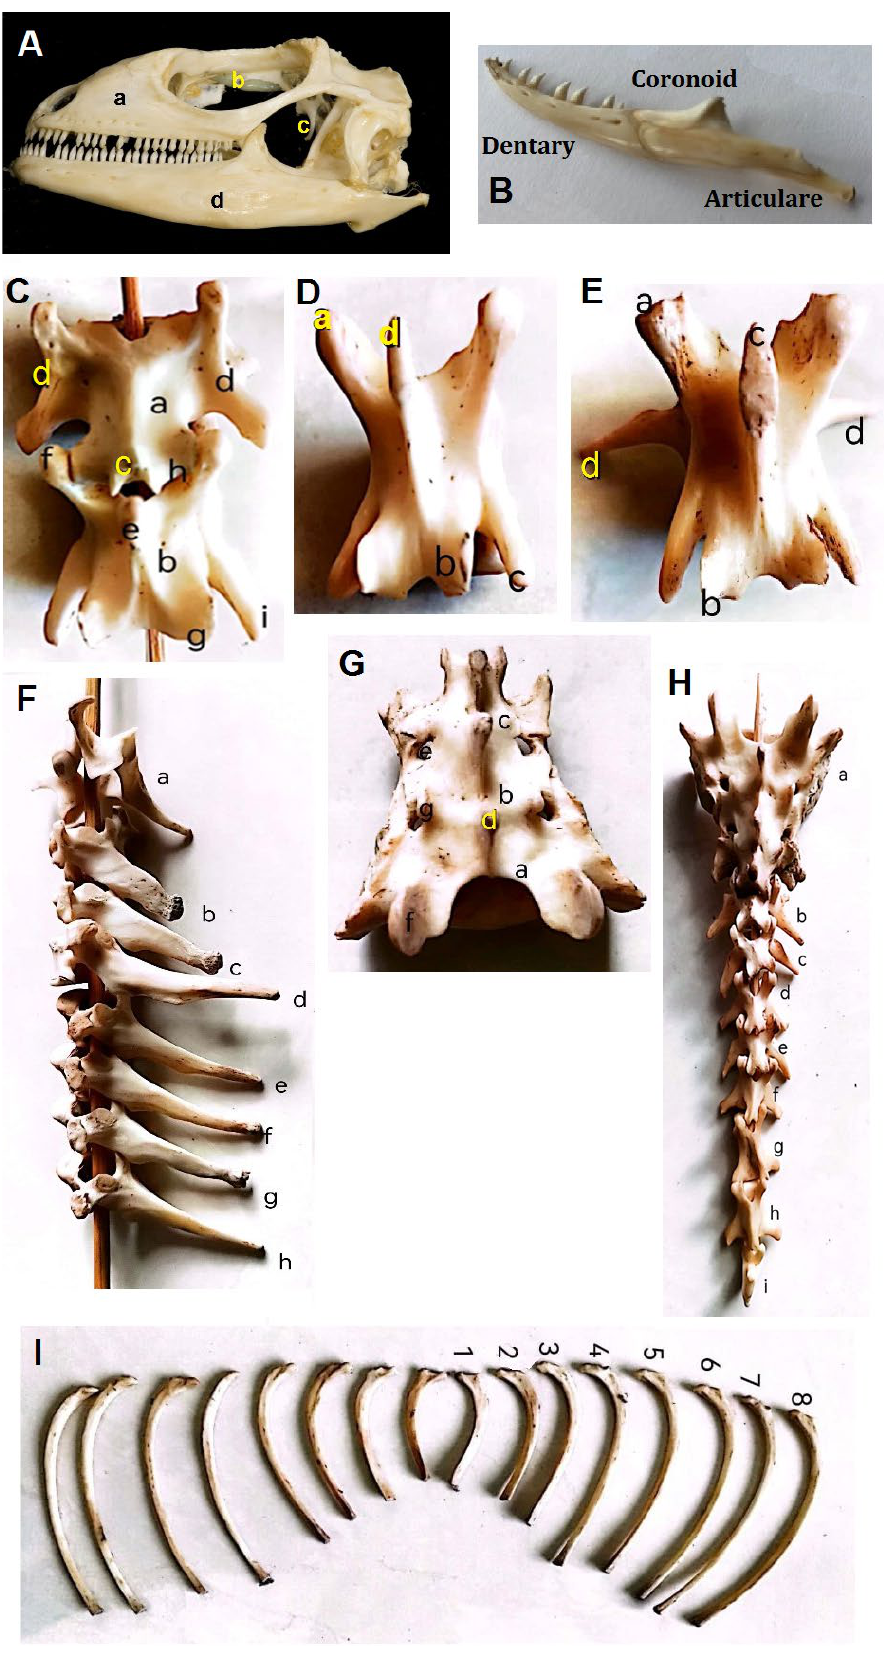
Figure 1. The mac ro